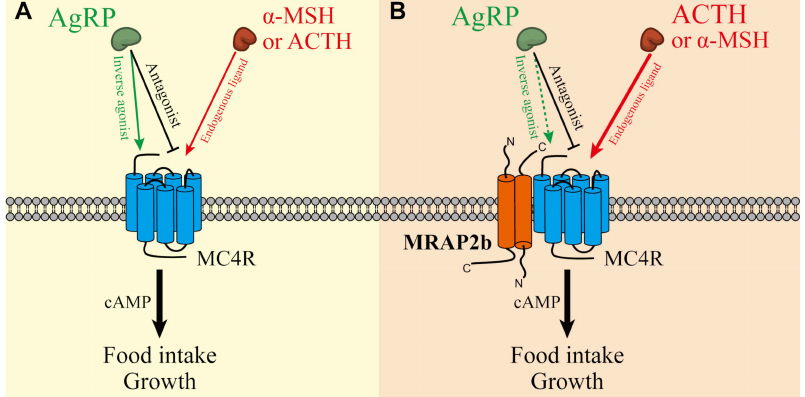
Figure 11. MC4R signaling system in tilapia. ( A ) In the absence of MRAP2b, α -MSH and ACTH can activate MC4R, while AgRP can act as an antagonist to block the action of α -MSH and ACTH. AgRP alone can also act as an inverse agonist to block the constitutive activity of MC4R. ( B ) In the presence of MRAP2b, MC4R interacts with MRAP2b and thus decreases the basal constitutive activity of MC4R and enhance its sensitivity and selectivity for ACTH. AgRP seems to mainly act as an antagonist to block the action of ACTH / α -MSH on MC4R activation. The interaction between these molecules in the hypothalamus determines MC4R signaling intensity, which may a ff ect the feeding and growth in tilapia and other vertebrate species (e.g., zebrafish, chickens,